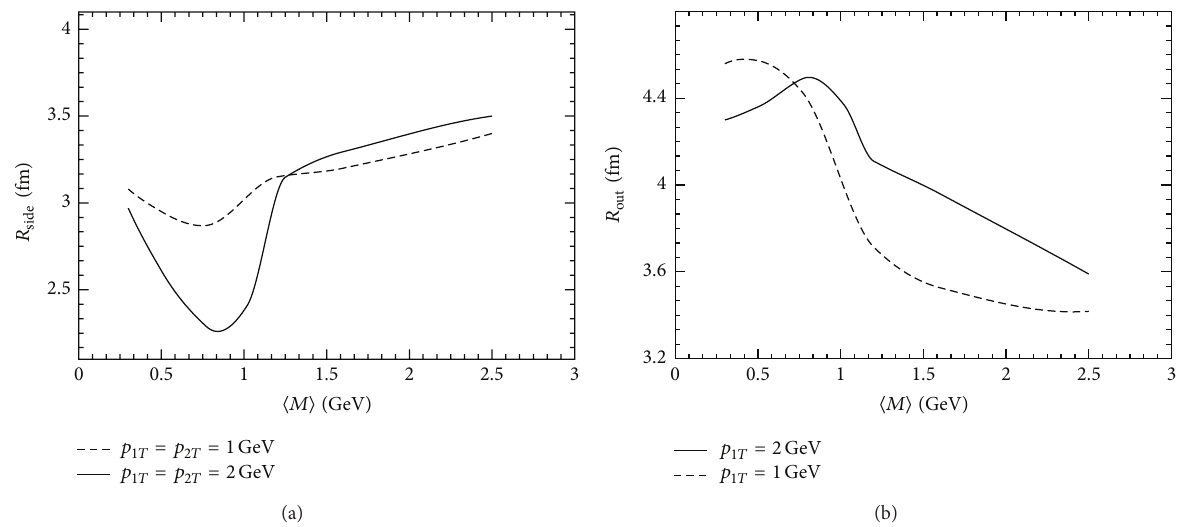
Figure 34: (a) Shows 𝑅 as a function of ⟨𝑀⟩ which is evaluated with 𝑝 1𝑇 = 𝑝 2𝑇 = 1 and 2GeV and 𝜓 2 = 0 and similarly (b) shows 𝑅 side function of for 𝜓 1 = 𝜓 2 = 0 and 𝑝 1𝑇 = 1 and 2 GeV ⟨𝑀⟩ . The 𝑝 1𝑇 = 1 and 2GeV results are shown as dashed line and solid line, respectively.